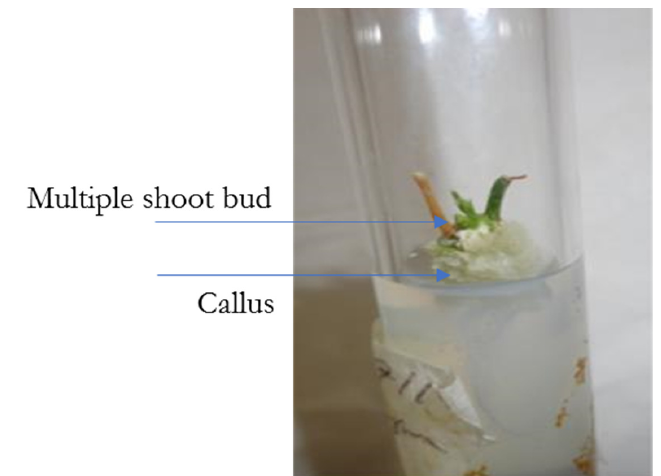
Figure 5. Basal callus with shoot buds obtained from nodal explant of E. cyclocarpum after four weeks of culture on ms supplemented with 2.7 µM NAA+ 2.2 µM BA